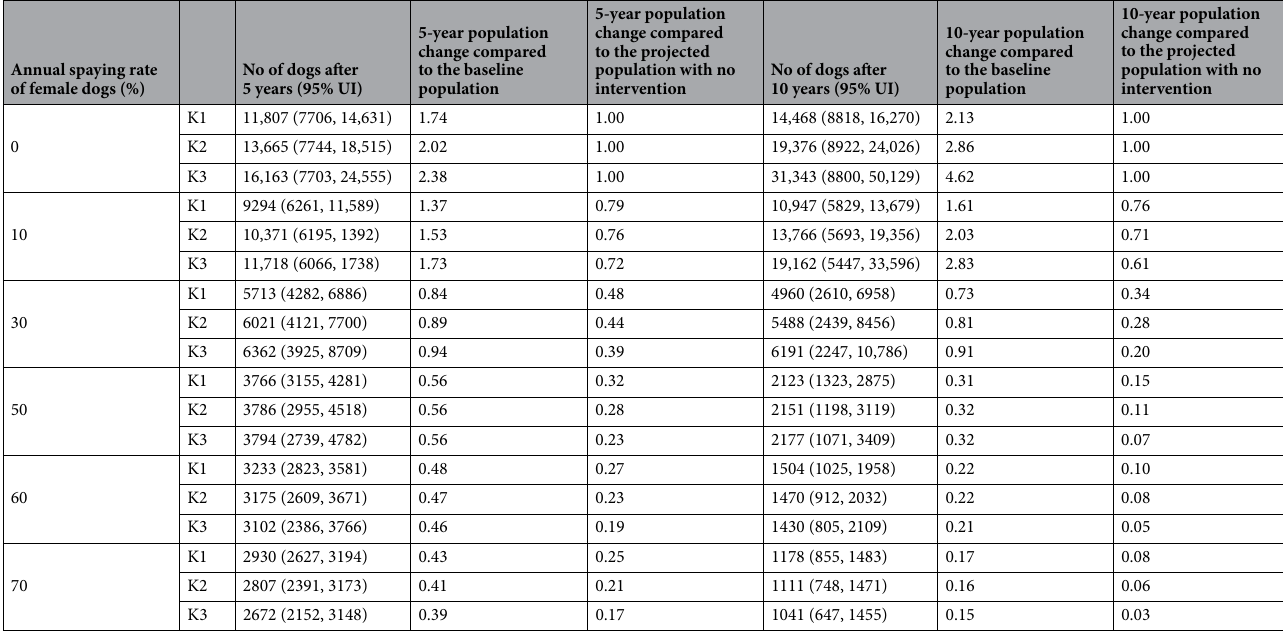
Table 2. Dog population model predictions according to five scenarios of female dog sterilization and three different levels of carrying capacities, 16,592 (K1), 24,200 (K2) and 55,000 (K3). UI Uncertainty Interval.